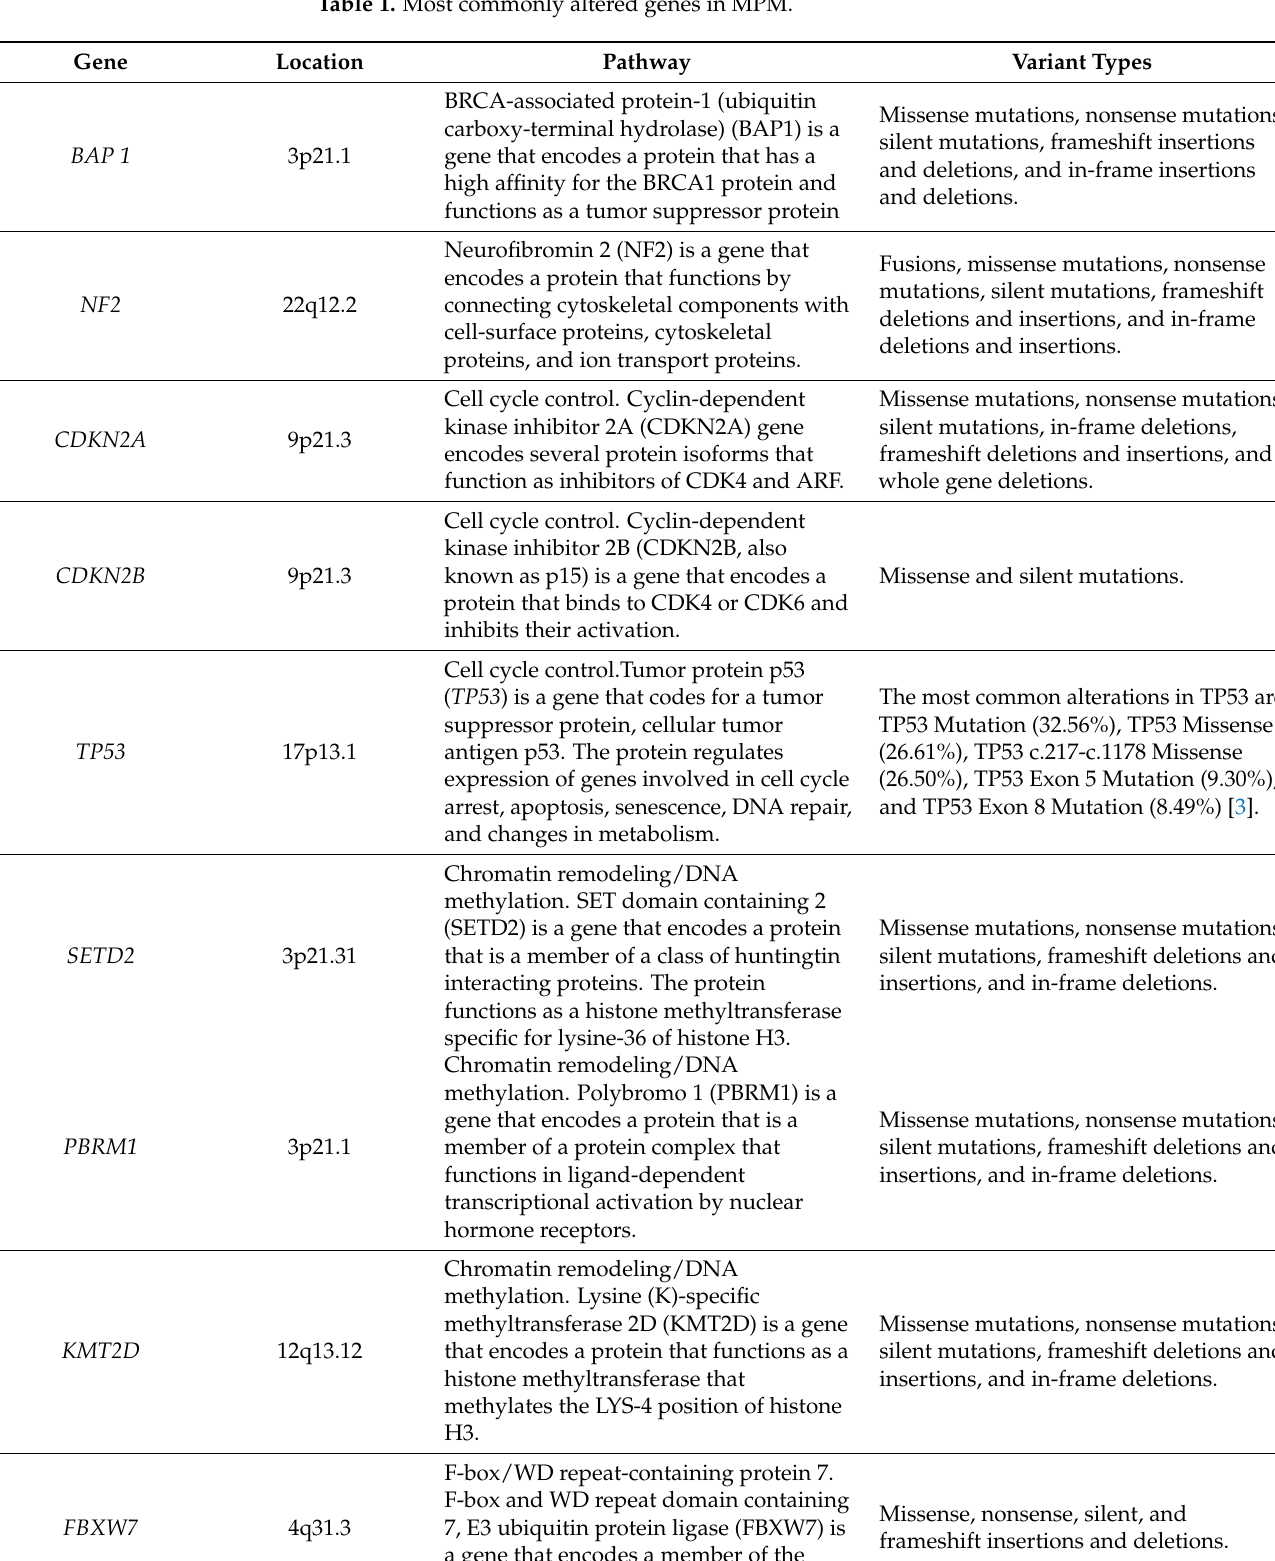
Table 1. Most commonly altered genes in